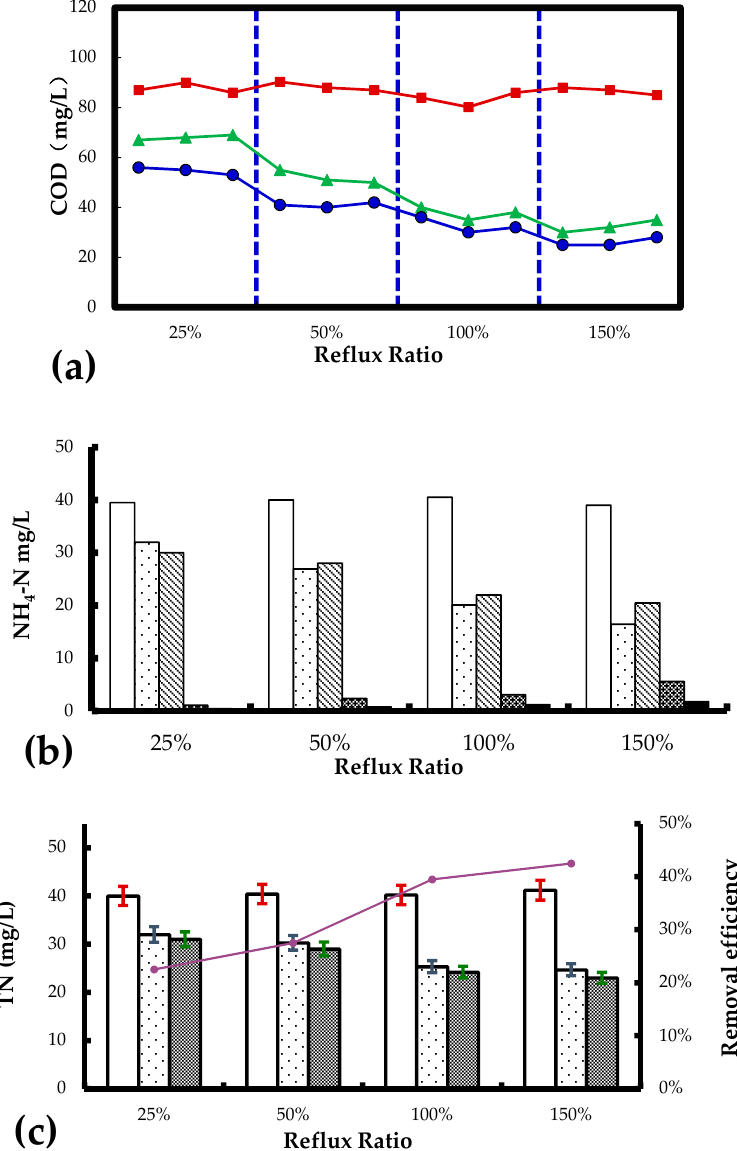
Figure 5. ( a ) Reflux ratio effect on COD removal in anoxic tank. anaerobic inflow; anoxic effluent water;